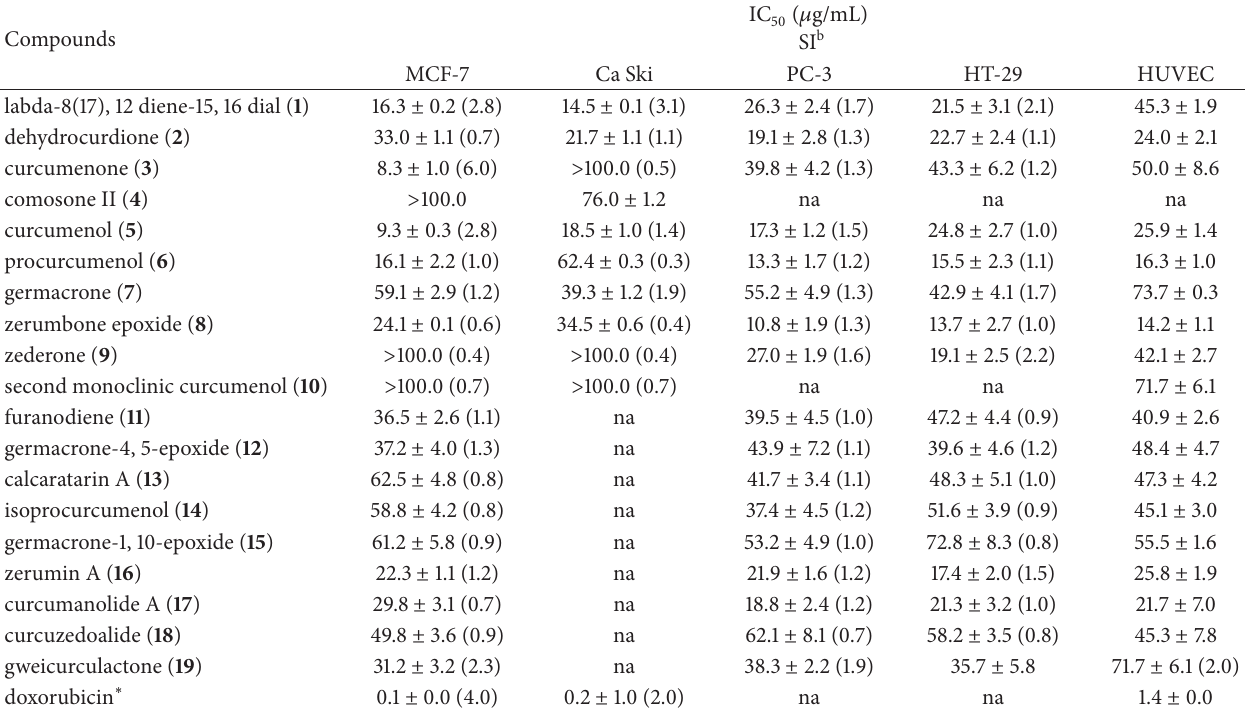
Table 2: Antiproliferative activity [IC values ( 𝜇 g/mL)] a and selectivity index of isolated compounds against selected human cancer cell lines 50 and human umbilical vein endothelial cells